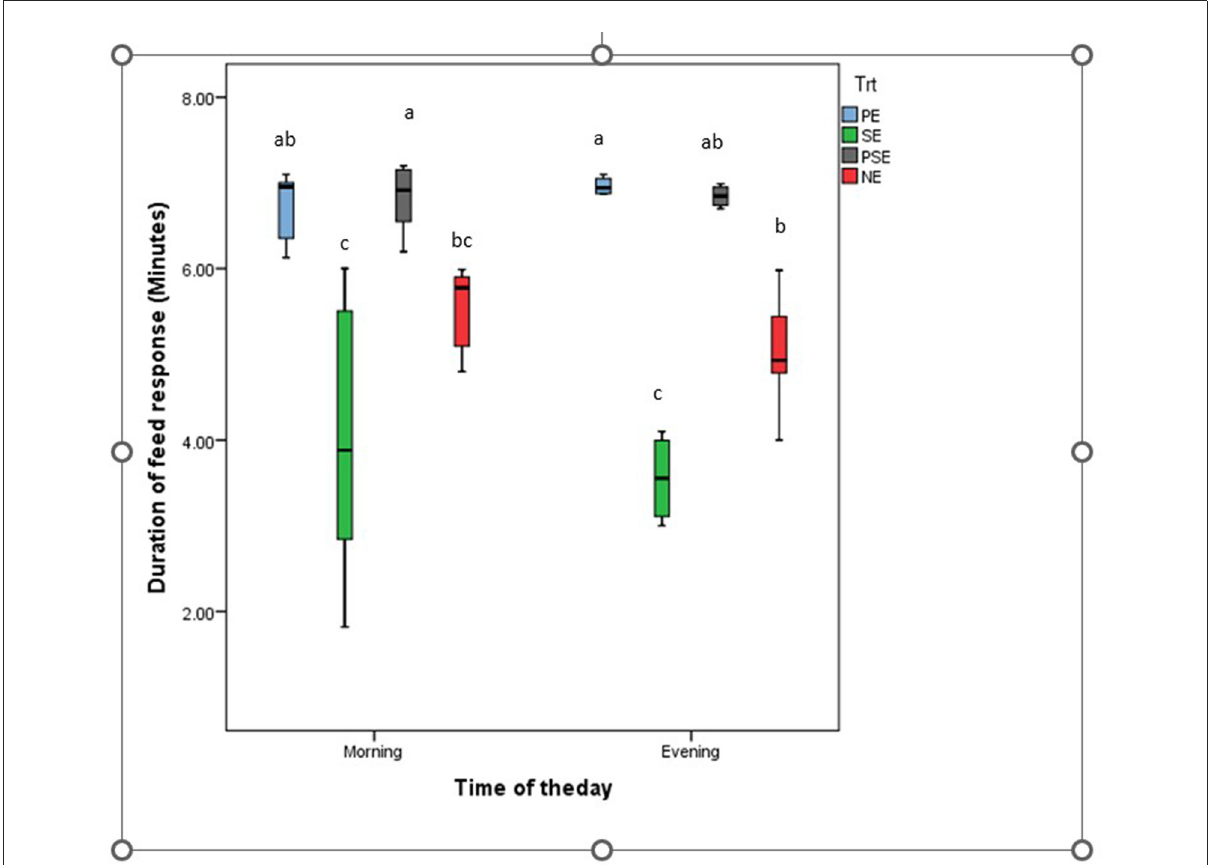
FIGURE4 Average duration of feed response in juveniles of Clarias gariepinus exposed to different forms of environmental enrichment (PE, Plant enriched; SE, substratum enriched; PSE, plant and substratum enriched; NE, non-enriched) at two different times (morning and evening) of the day. Significant differences between treatments at each experimental period are marked with different superscripts at p < 0.05.